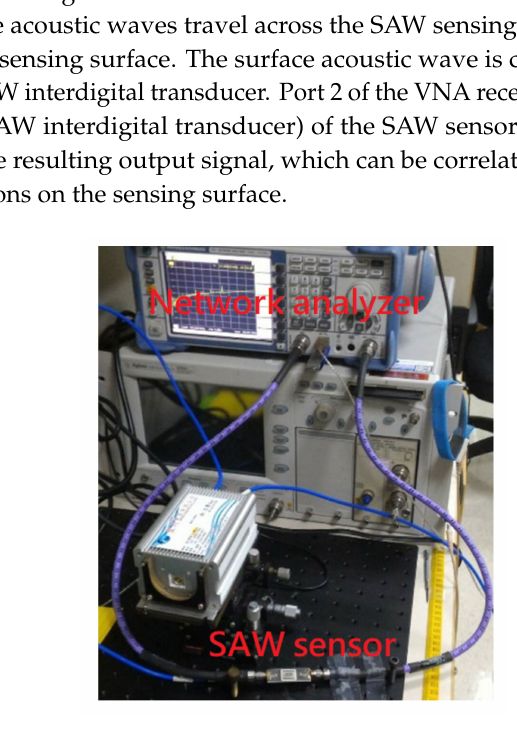
Figure 4. The measurement system for the frequency response of SAW